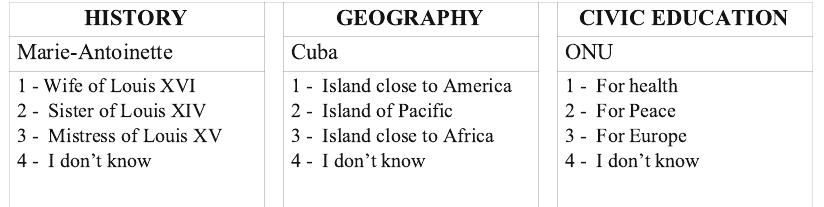
Examples ofquestions for each ofthe eight subjects in the MCQ ofgrade 8: the questionnaire comprises hundred questions by subject (800 on the whole) (adapted from MCQ in French for this